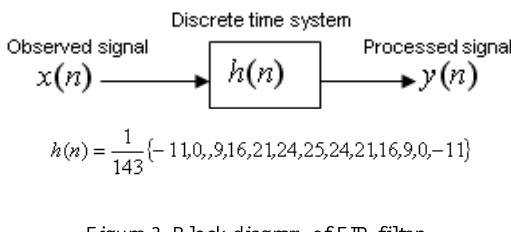
Figure 3. Block diagram of FIR filter